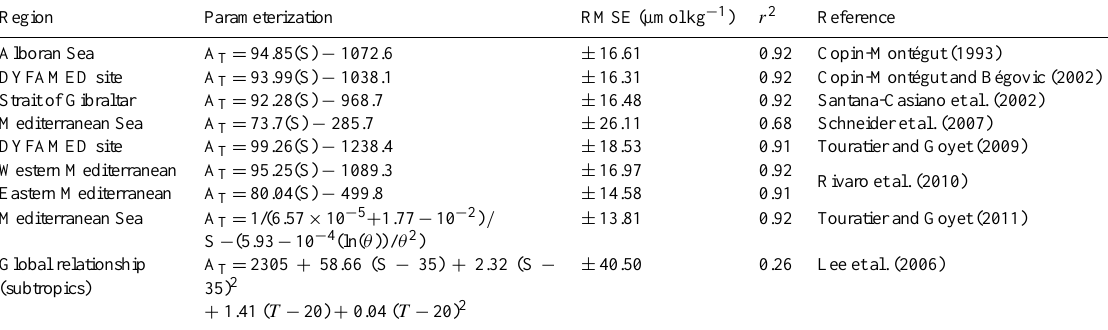
Table 3. Performance of the different parameterizations for the estimation of A T applied independently to the training data set of this study.